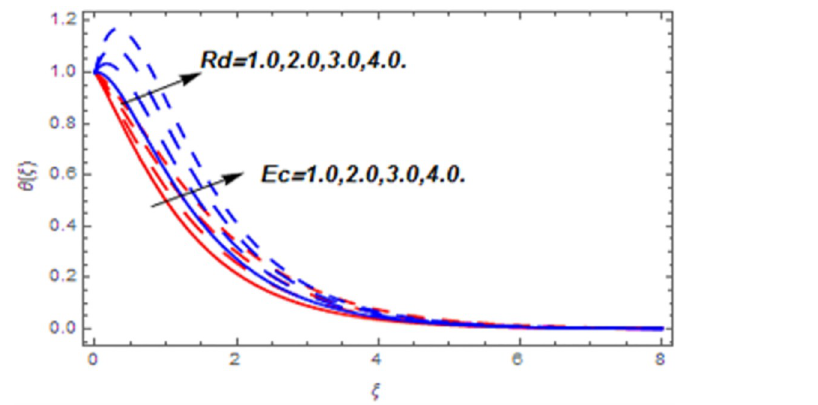
Fig 6. Thermal profiles versus Eckert number and radiation parameter.